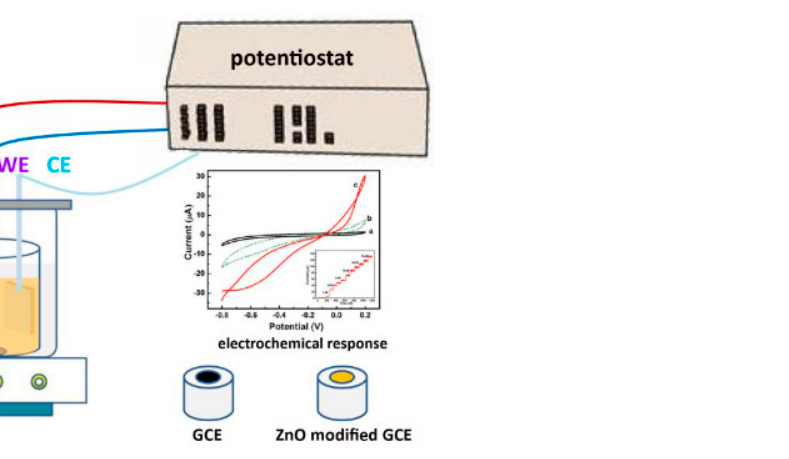
Figure 11. Schematic illustration of the equipment used for analysis with an electrochemical sensor. Reprinted with permission from [130]. Table 7. Performances of various electrochemicals sensors based on CPs and MIPs to detect the Phe, Tyr, and Trypt AAs. A